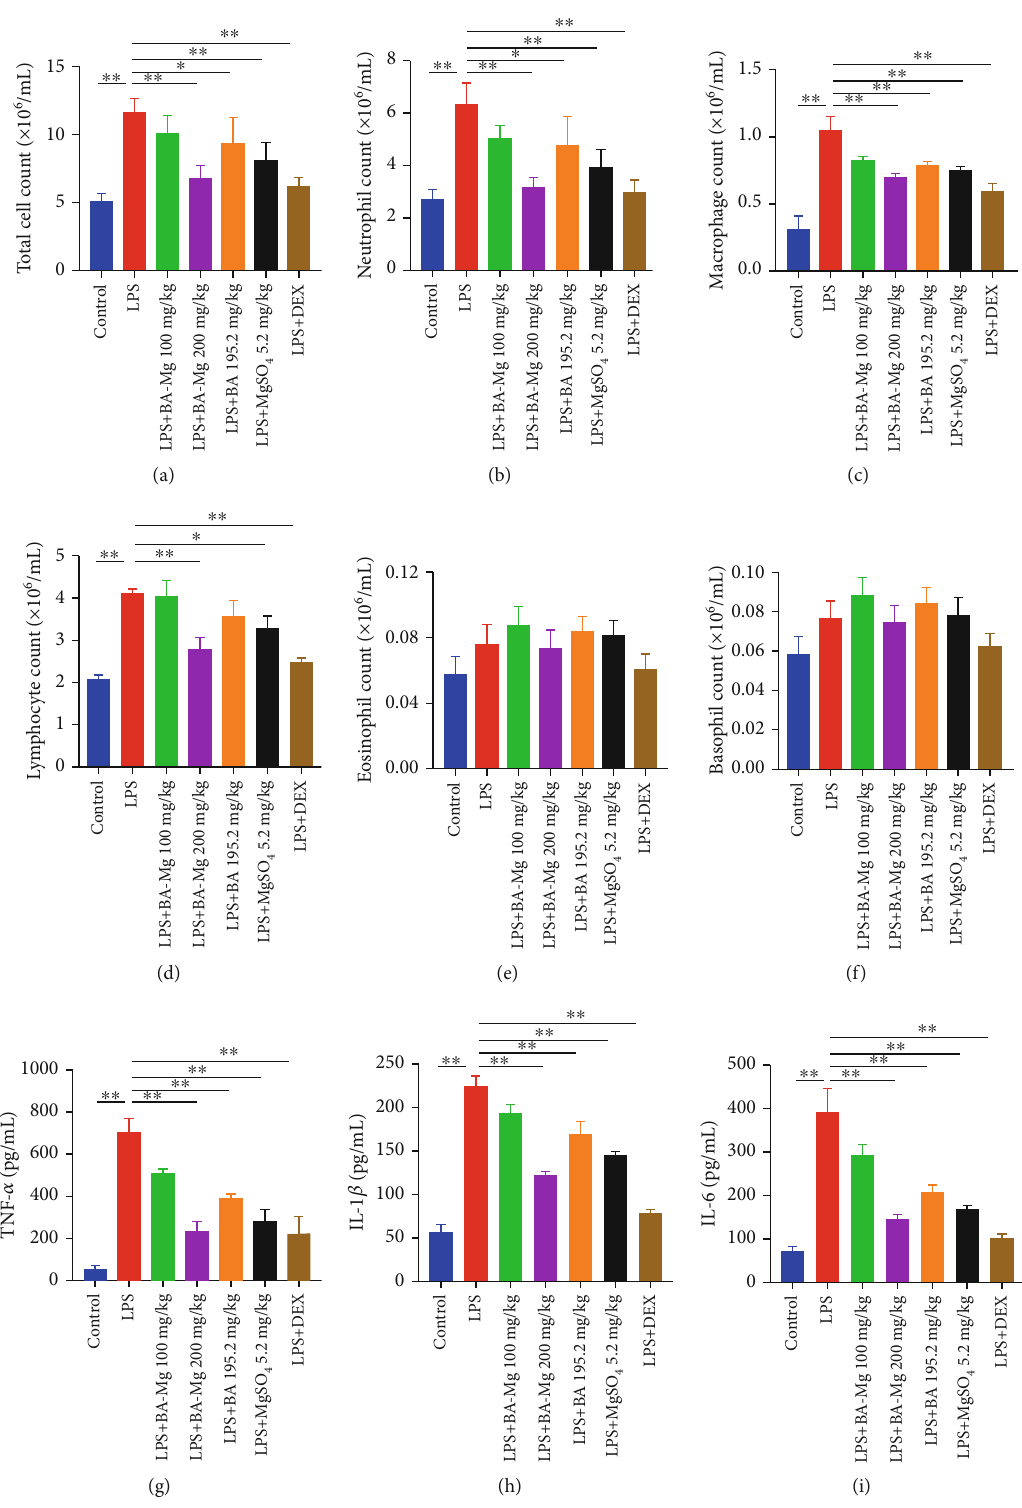
Figure 3: BA-Mg attenuated in fl ammatory cell in fi ltration and proin fl ammatory cytokine expressions in BALF: (a – f) in fl ammatory cell counts; (g – i) proin fl ammatory cytokines. Data were represented as mean ± SD ( n = 5 ). ∗ P < 0 : 05 , ∗∗ P < 0 : 01 versus LPS